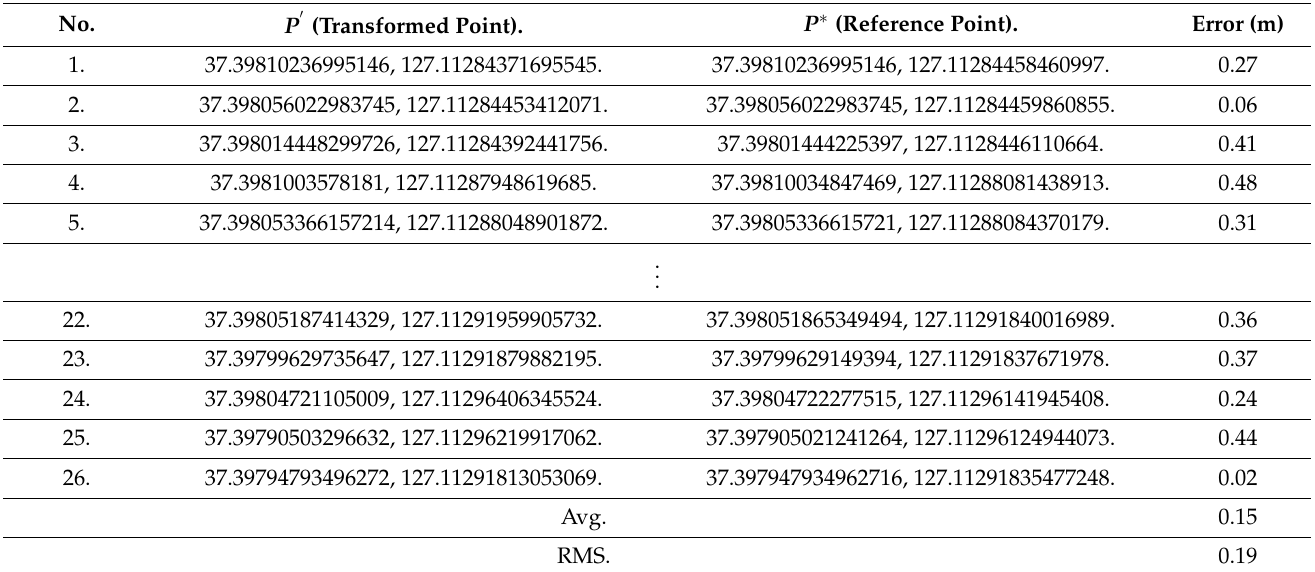
Table A1. Results of the Evaluation of Projection Points on World